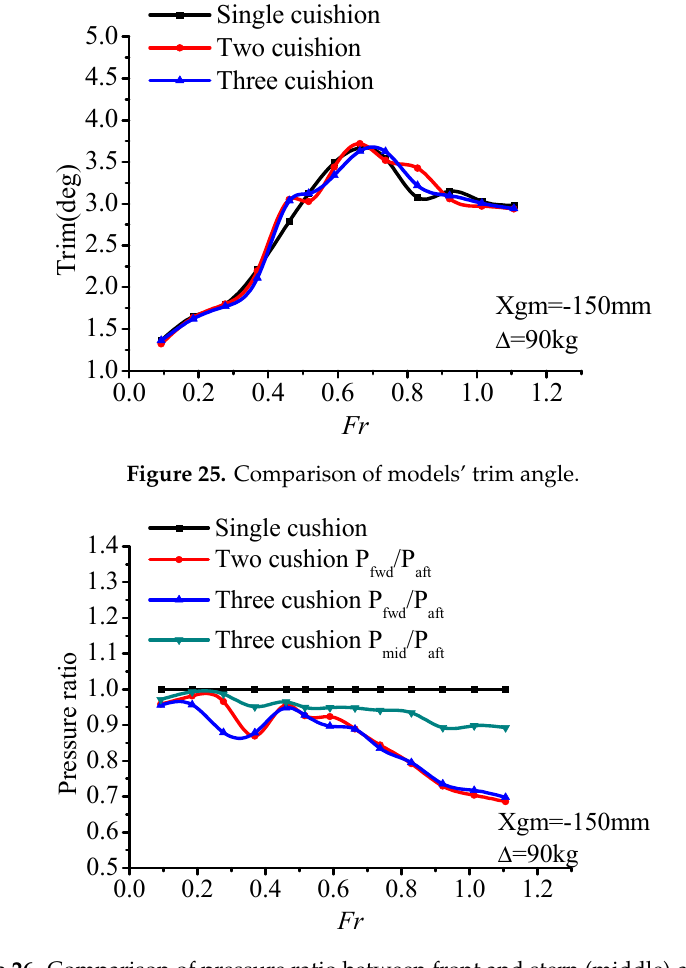
Figure 26. Comparison of pressure ratio between front and stern (middle) chamber.